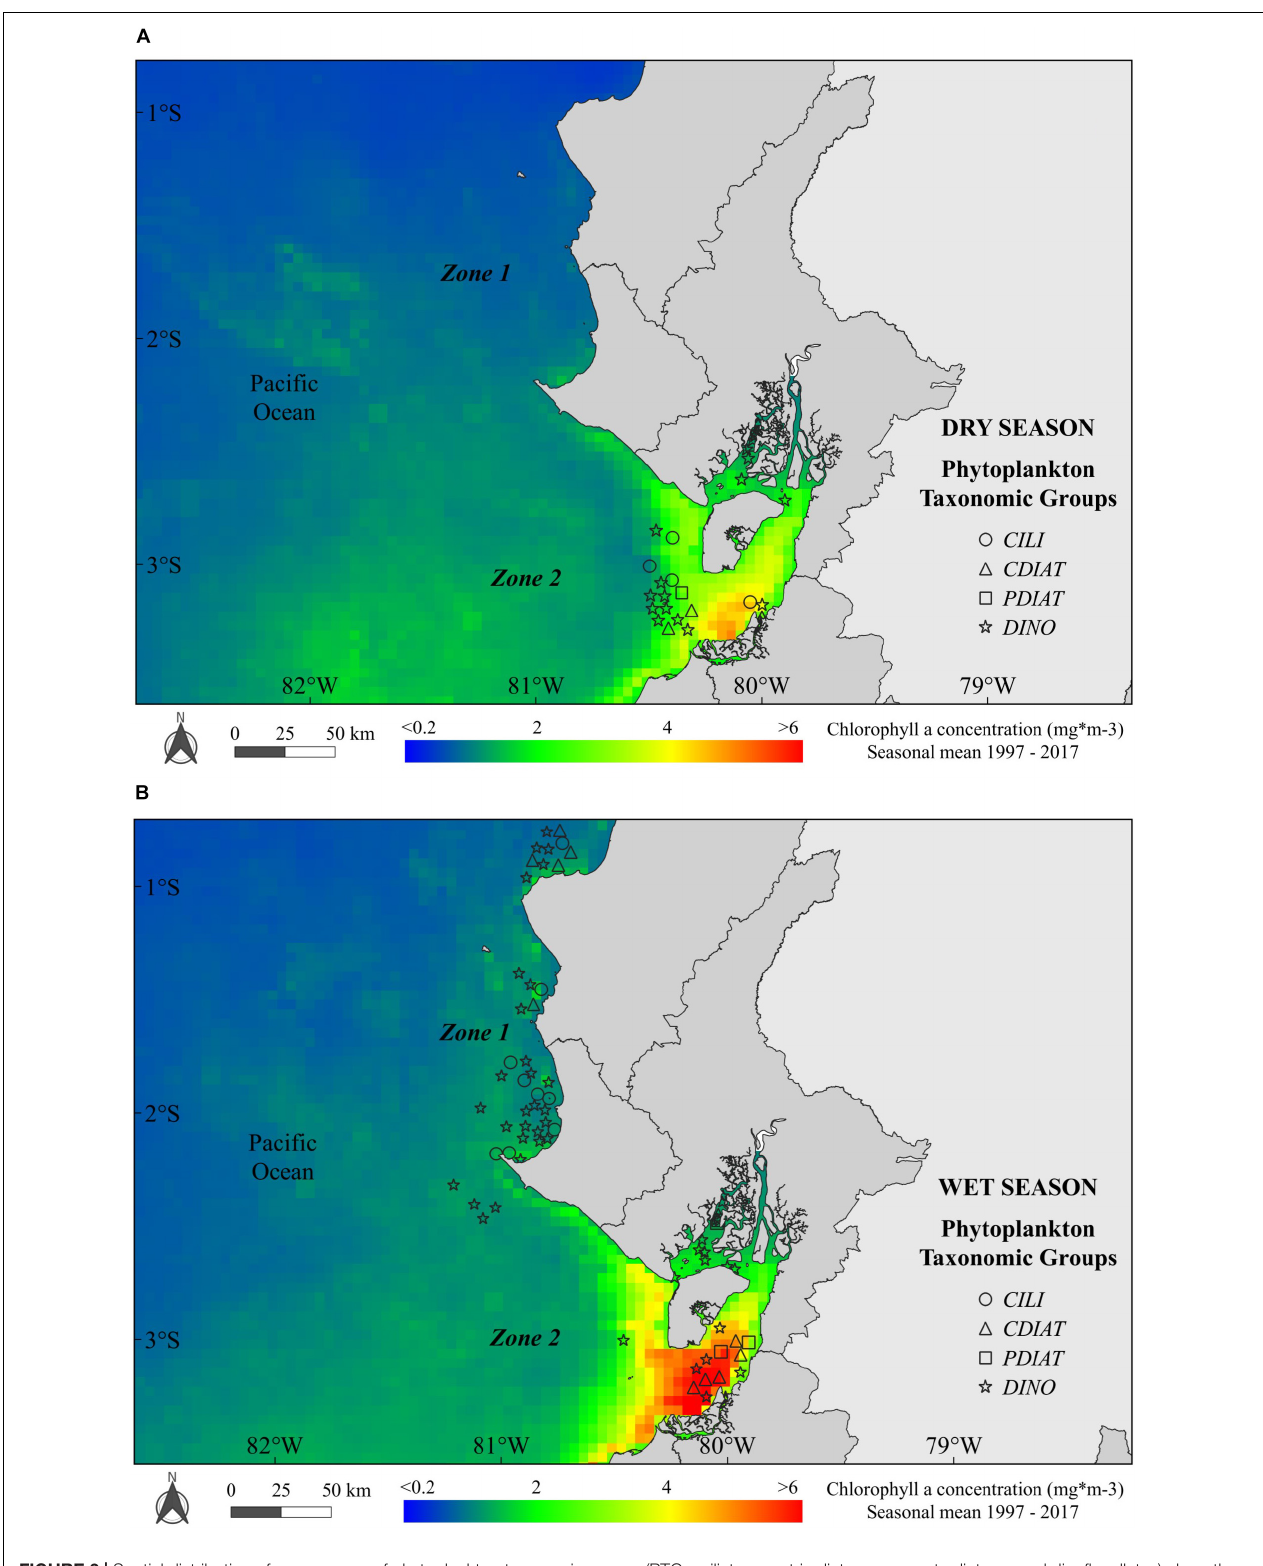
FIGURE 3 | Spatial distribution of occurrences of phytoplankton taxonomic groups (PTGs: ciliates, centric diatoms, pennate diatoms and dinoflagellates) along the Ecuadorian coast during (A) the dry season—occurrences of PTGs and (B) the wet season—occurrences of PTGs in Zones 1 and 2 of the study area. Background colors show the seasonal mean of chlorophyll a for the dry and wet